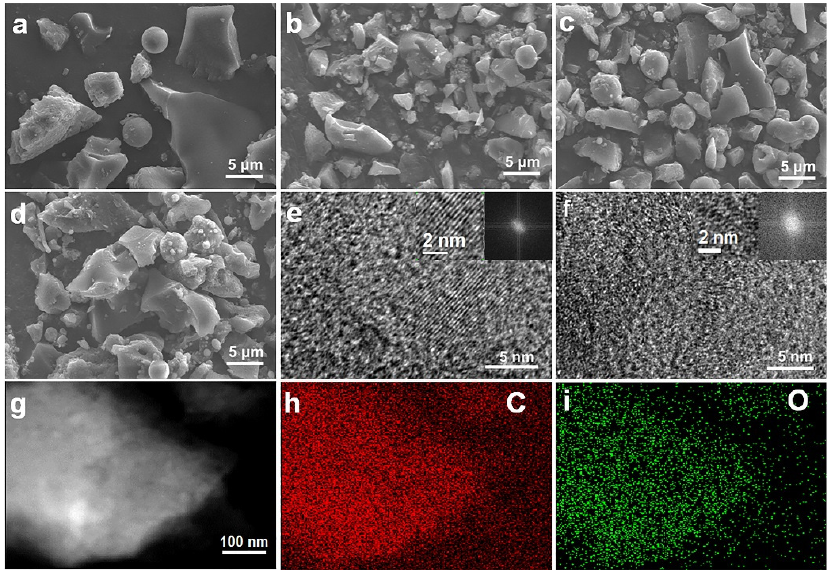
Figure 1. SEM images of ( a ) DQC, ( b ) C − 1000, ( c ) C − 1000 Ar − 600, and ( d ) C − 1000 H 2 − 600. HRTEM images of ( e ) C − 1000 Ar − 600, and ( f ) C − 1000 H 2 − 600; inset: partial magnified images and FFT images. ( g ) TEM image of C − 1000 H 2 − 600. EDS mapping of C − 1000 H 2 − 600 with ( h ) C element and ( i ) O